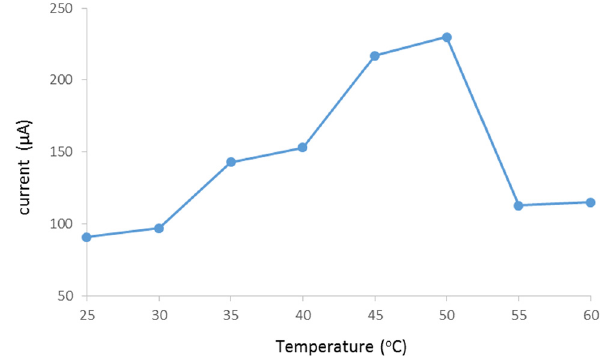
Figure 9: E ff ect of temperature on the response of the enzyme electrode at + 0.12 V in the range of − 0.1 to 1.0 V applied potential, pH